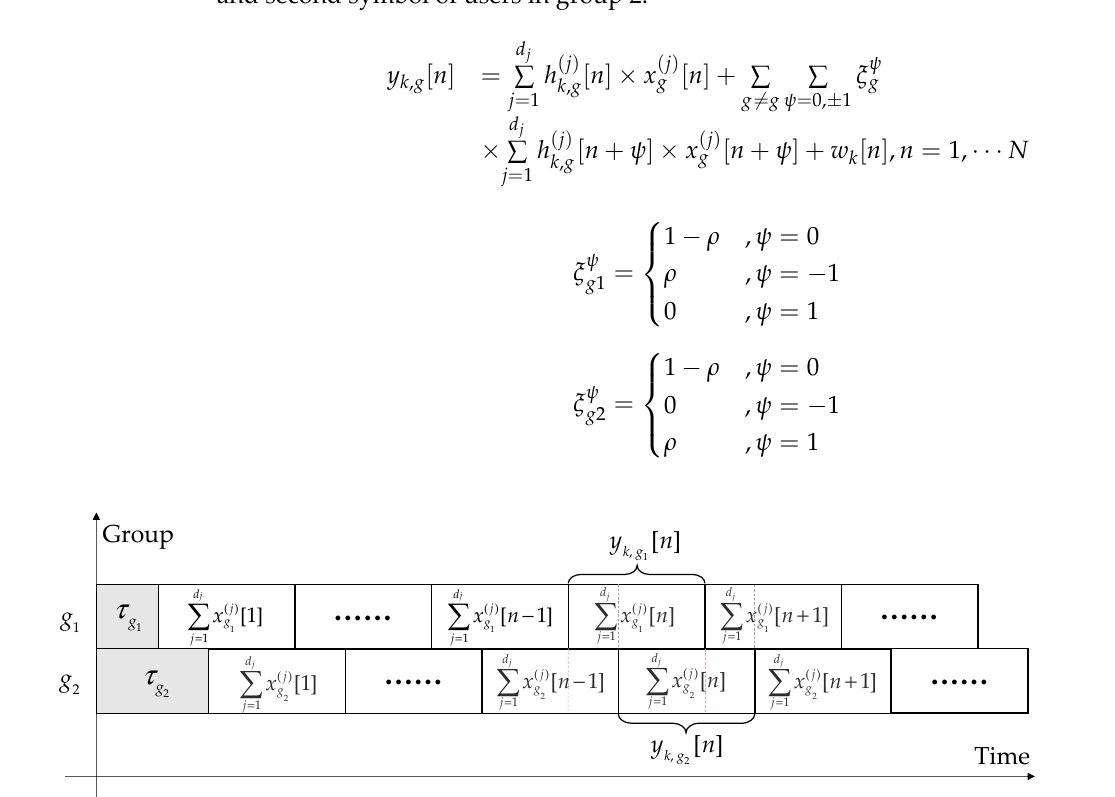
Figure 7. Receiving signal structure.